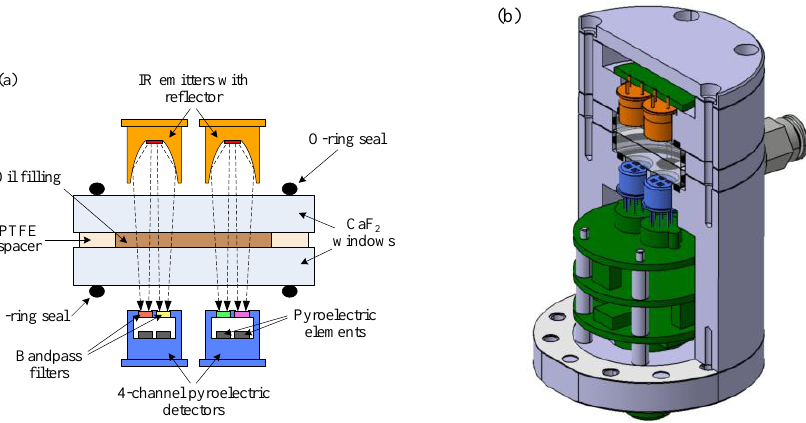
Figure 3. ( a ) Functional principle of the sensor implementation. The light emitted by two infrared (IR) emitters travels through the measurement cell containing the oil sample being tested. It is then detected by two four-channel pyroelectric detectors equipped with different optical bandpass filters; ( b ) Sectional computer-aided design model of the sensor prototype.